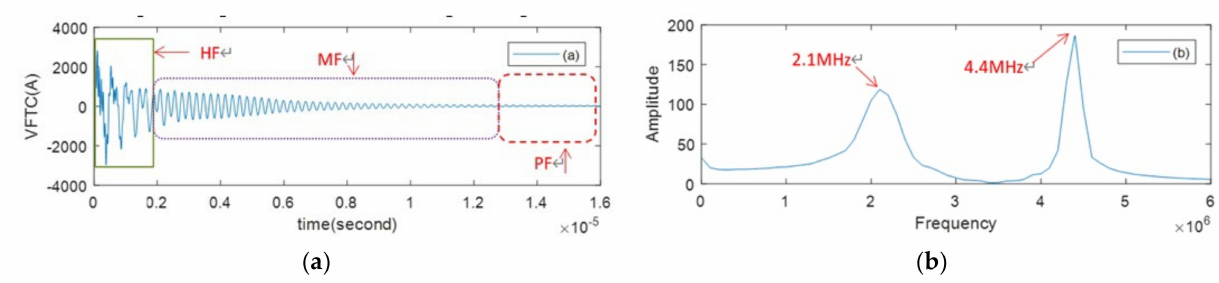
Figure 6. VFTC waveforms at GIS bus (ECT) for disconnector switching (DS) operation (S. No1): ( a ) single current waveform; ( b ) frequency spectra of the VFTC.